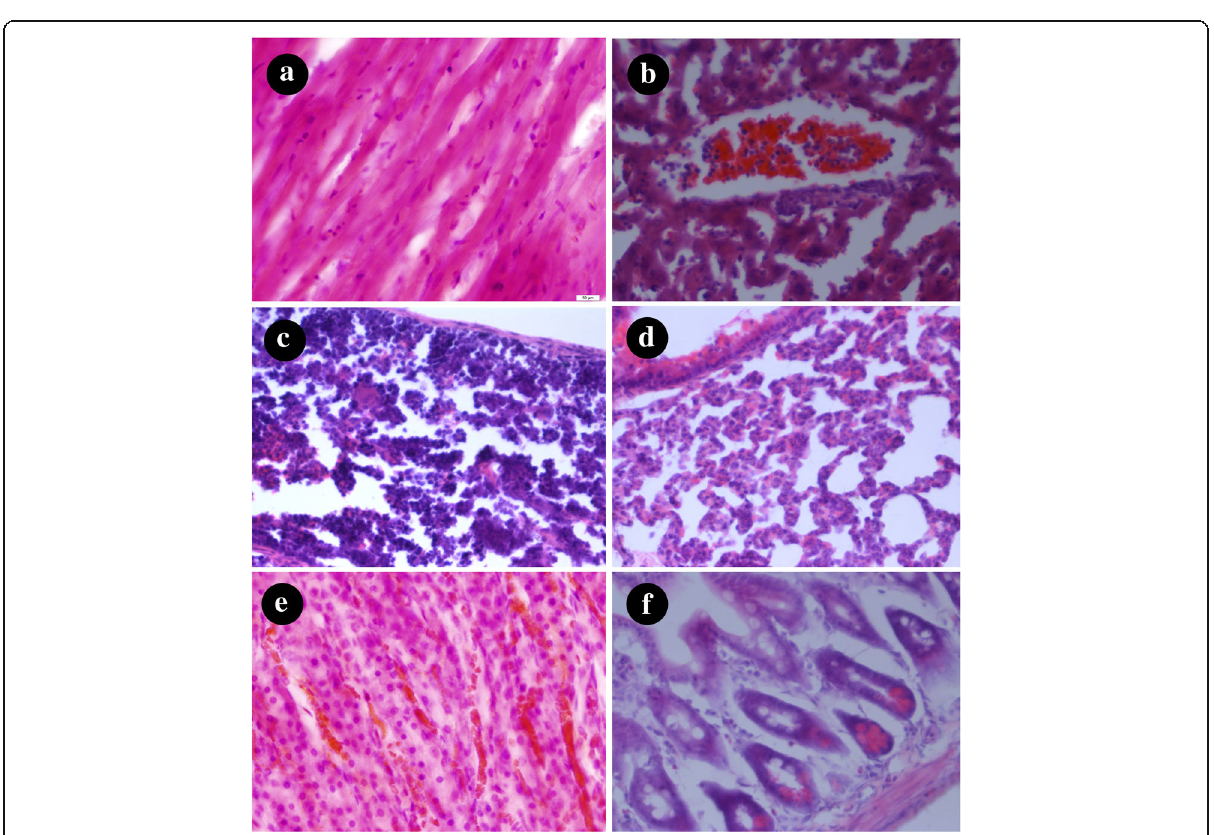
Fig. 5 Tissue sections stained with H&E: a heart, b liver, c spleen, d lung, e kidney, and f intestine. The scale bars represent 100 mm